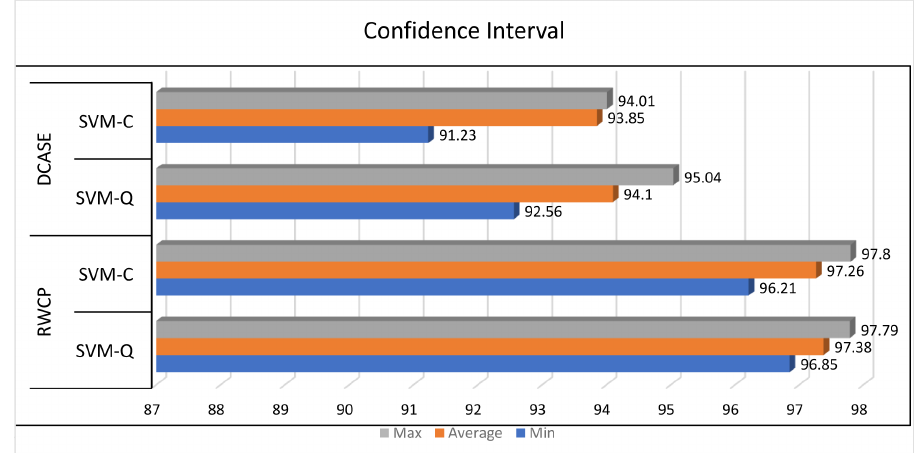
Figure 9. Confidence interval against two selected classifiers on benchmark